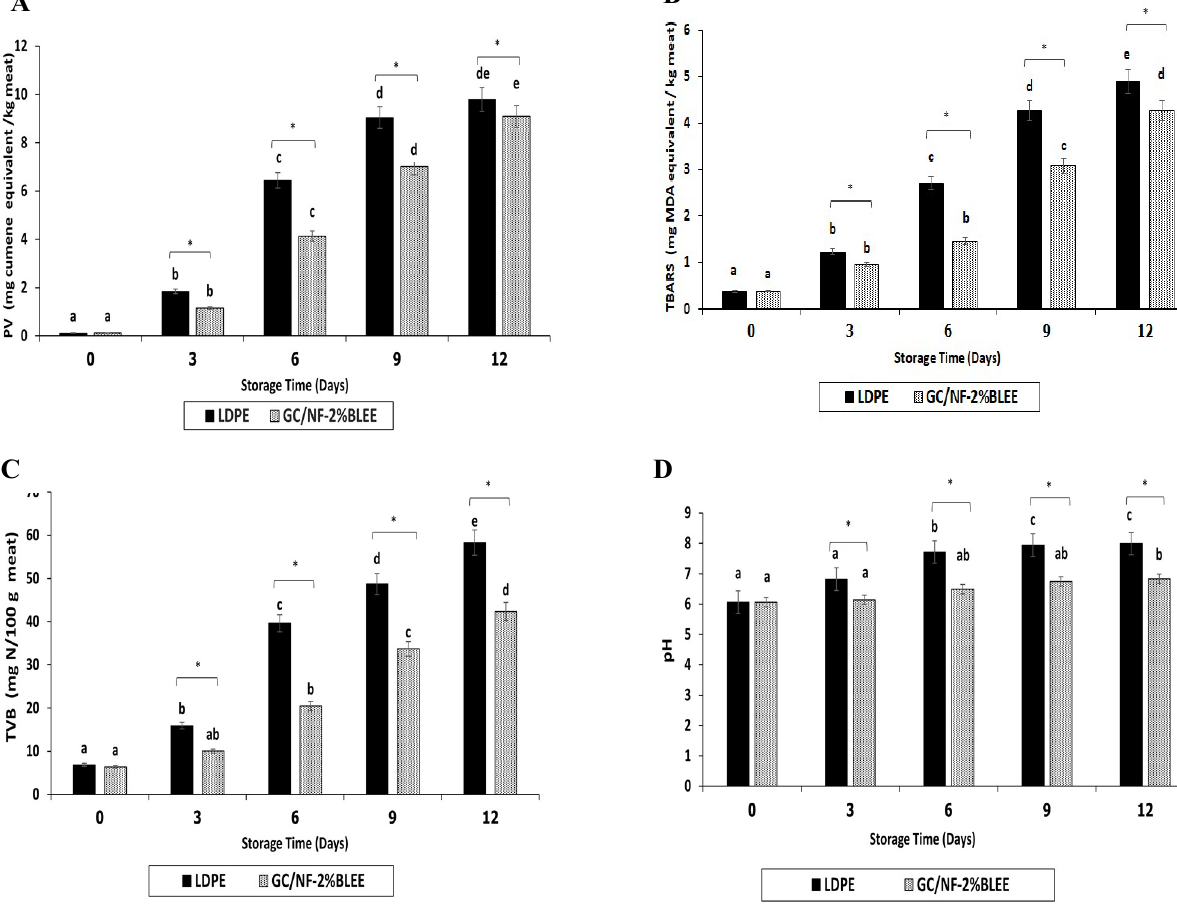
Figure 4. Peroxide value (PV) ( A ), thiobarbituric acid reactive substances (TBARS) ( B ), total volatile base (TVB) content ( C ), and pH ( D ) of tilapia slices packaged in different bags during 15 days of refrigerated storage. Bars represent standard deviation (n = 3). Single asterisk (*) indicates significant difference ( p < 0.05). Different lowercase letters of samples packaged in the same bag indicate significant difference ( p < 0.05).